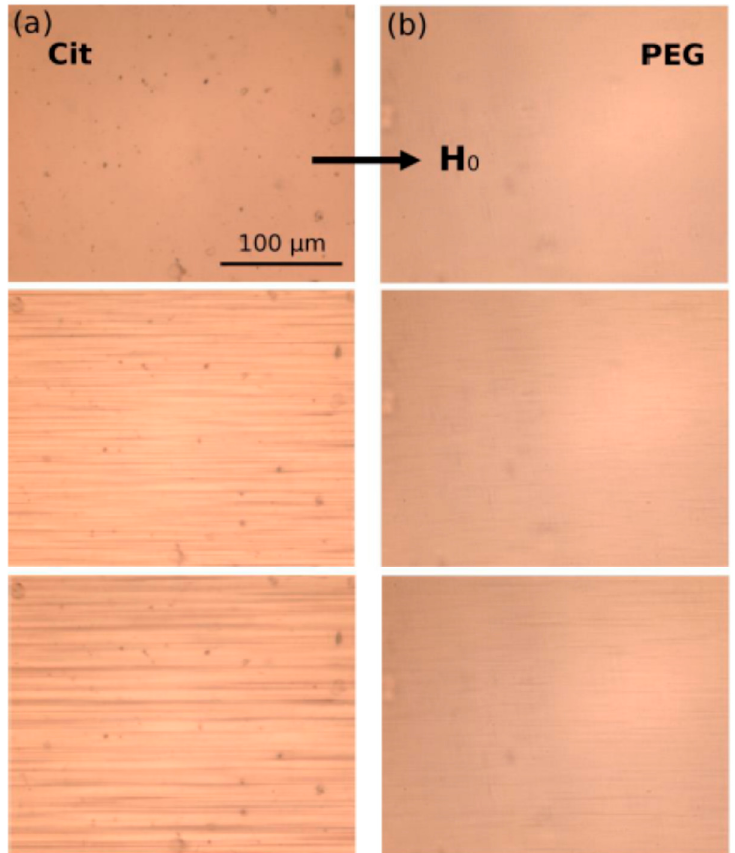
Figure 28. Optical microscopy images of aqueous suspensions of a) citrated, and b) PEGylated MNCs in an external uniform DC magnetic field of intensity 13.5 kA/m. Each row corresponds to the elapsed time from the moment of the magnetic field application t = 0 (upper row), 5 and 10 min. (Reprinted from [274] under Open Access license).